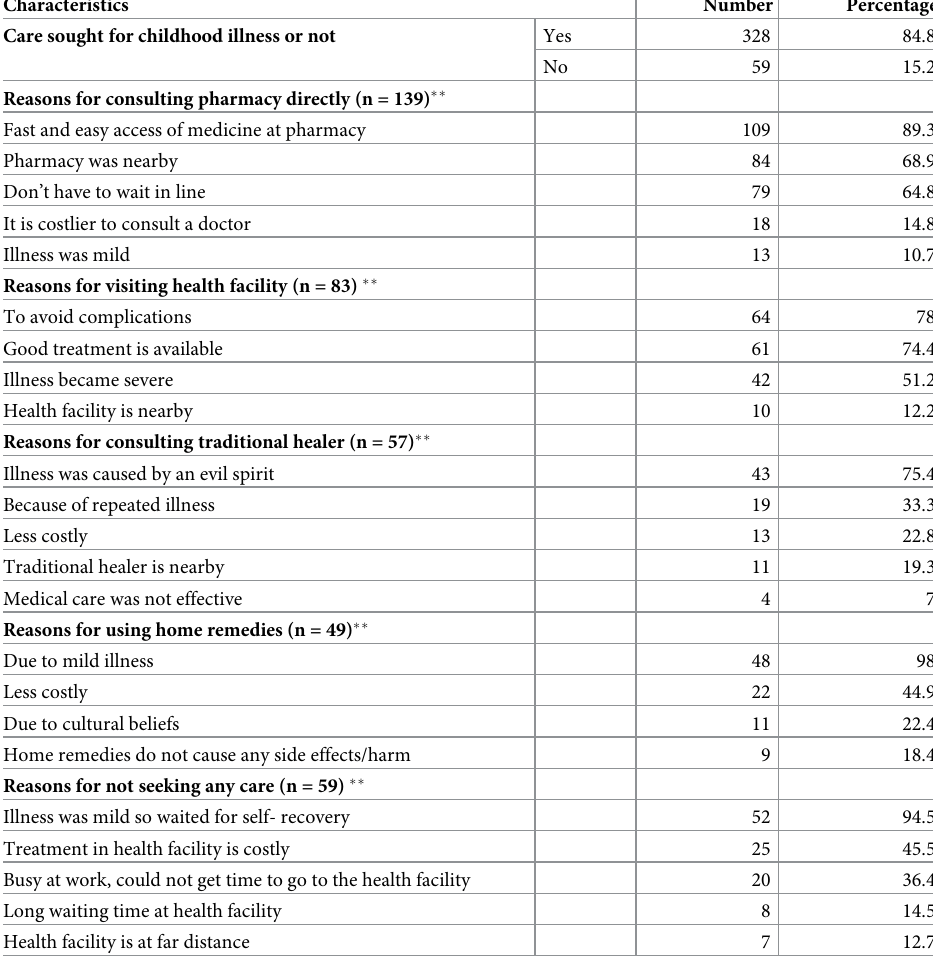
Table 2. Distribution of respondents according to the reasons for different health care seeking behavior.